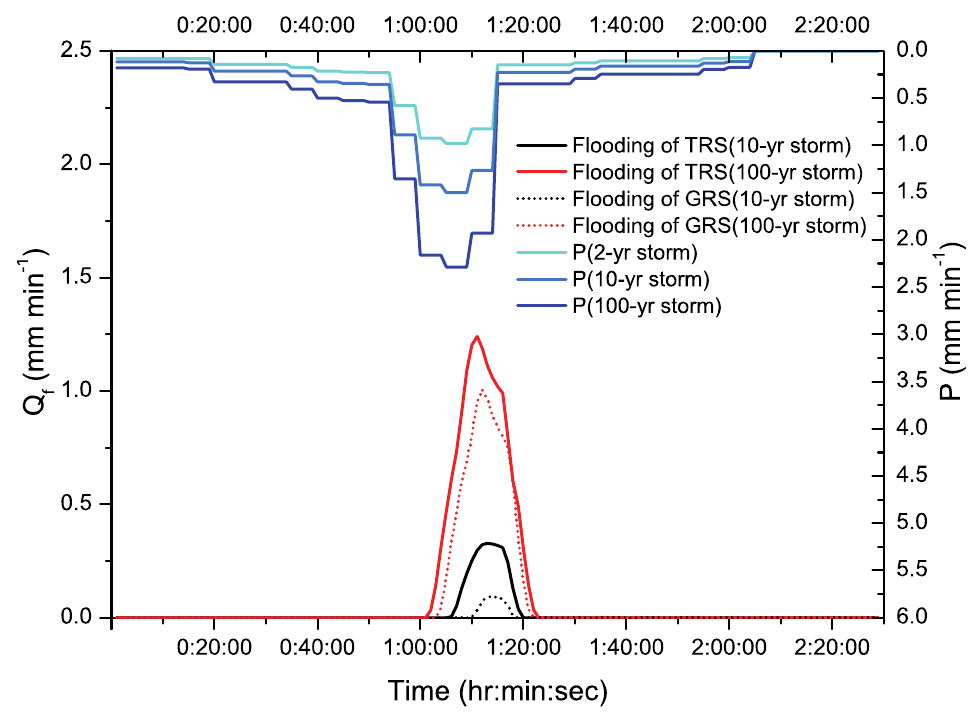
Figure 6. Comparison of flood flow between TRS and GRS for 3 single precipitation events (2-yr, 10-yr, and 100-yr). P: precipitation; Q f : discharge of flood.